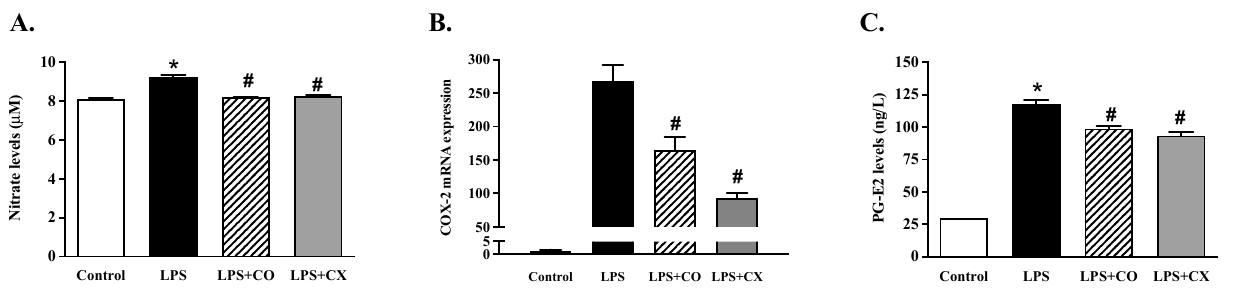
Figure 3. Impact of CO on inflammatory mediators in LPS-activated cells. Cells were activated with LPS and then treated with either 2% CO or 10 µM CX for 24 h. This study evaluated the NO production ( A ), COX − 2 mRNA expression ( B ), and PGE2 generation ( C ). Values displayed are mean ± S.E.M ( n = 5), * p < 0.05 vs. control and # p < 0.05 vs. LPS.